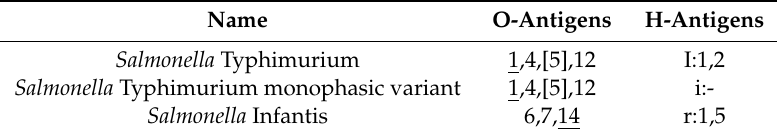
Table 5. Antigenic formula of Salmonella serovars used in the study. Name O-Antigens H-Antigens Salmonella Typhimurium 1,4,[5],12 Salmonella Typhimurium monophasic